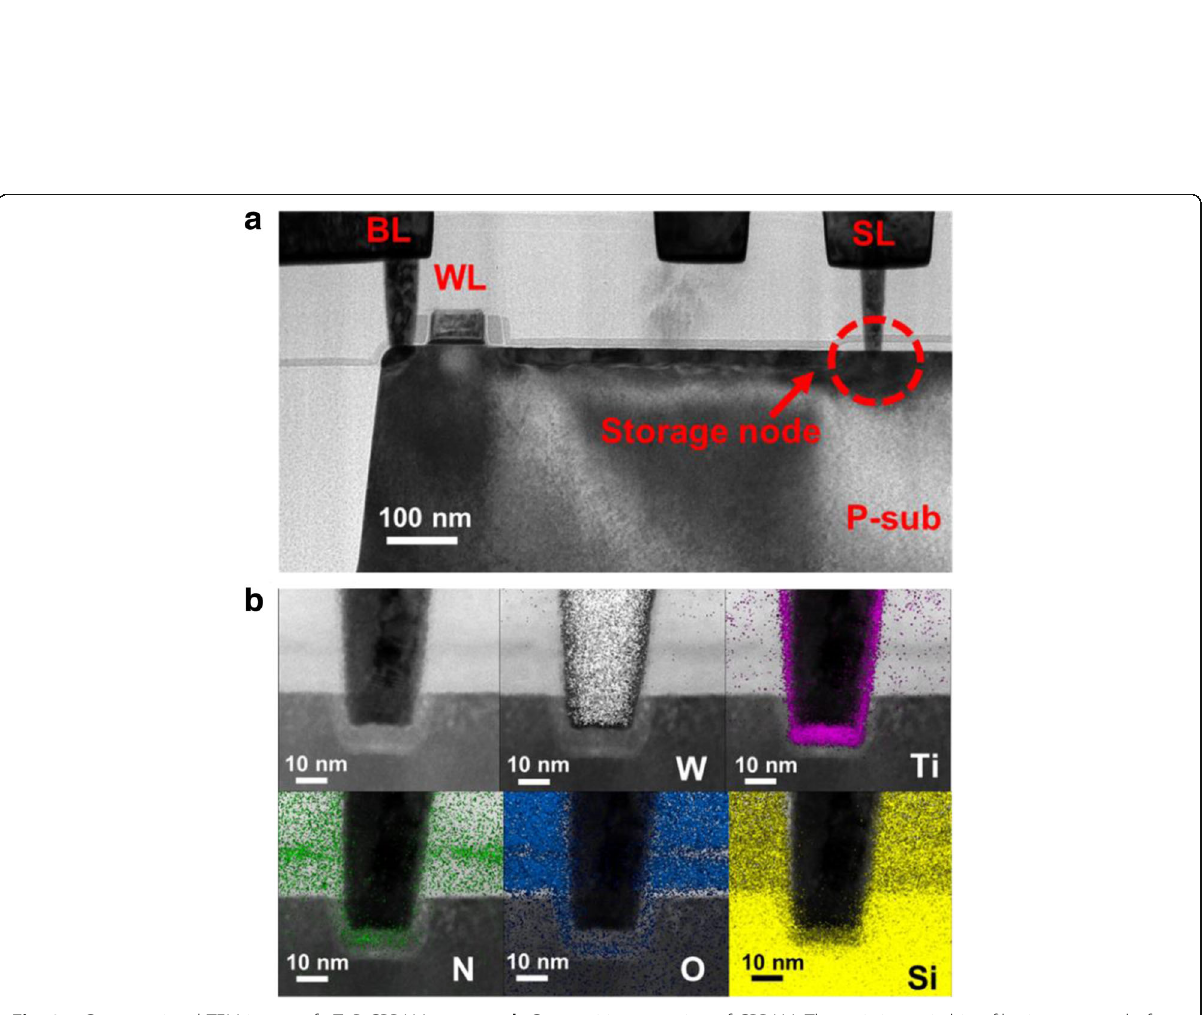
Fig. 2 a Cross-sectional TEM image of 1T1R CRRAM structure. b Composition mapping of CRRAM. The resistive switching film is composed of TiN/TiON/SiO 2 sandwiched between the top tungsten plug and bottom Si